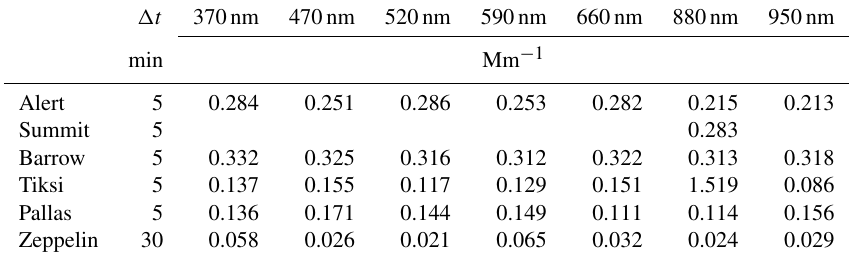
Table 3. Standard deviation of σ 0 ( δσ 0 ) in Mm − 1 when measuring particle-free air. These values can be used in Eq. (10) for an arbitrary value of σ 0 and (cid:49)t